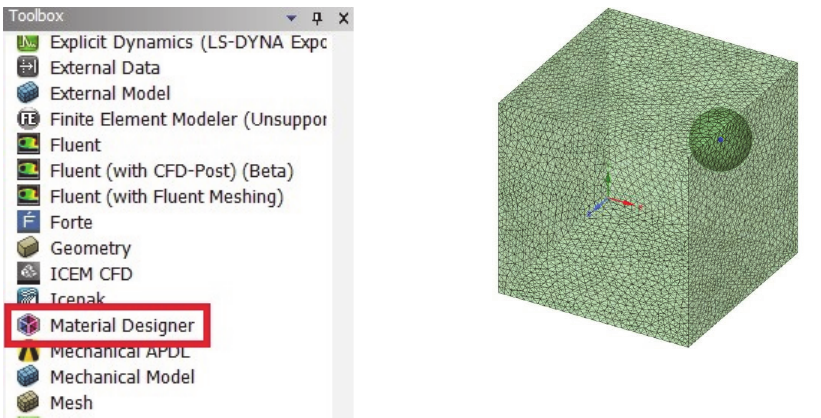
Figure 9: (a) Material Designer module (b) RVE created in Material